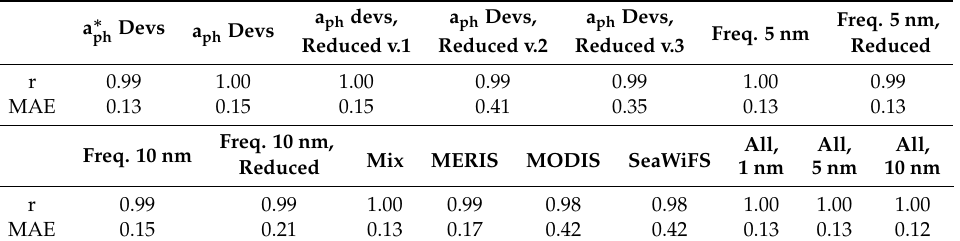
Table 4. Correlation coefficients (r) and mean absolute errors (MAE) calculated between the retrieved cyanobacteria chl-a concentrations and their input concentrations. Abbreviations for the band settings are the same as in Table